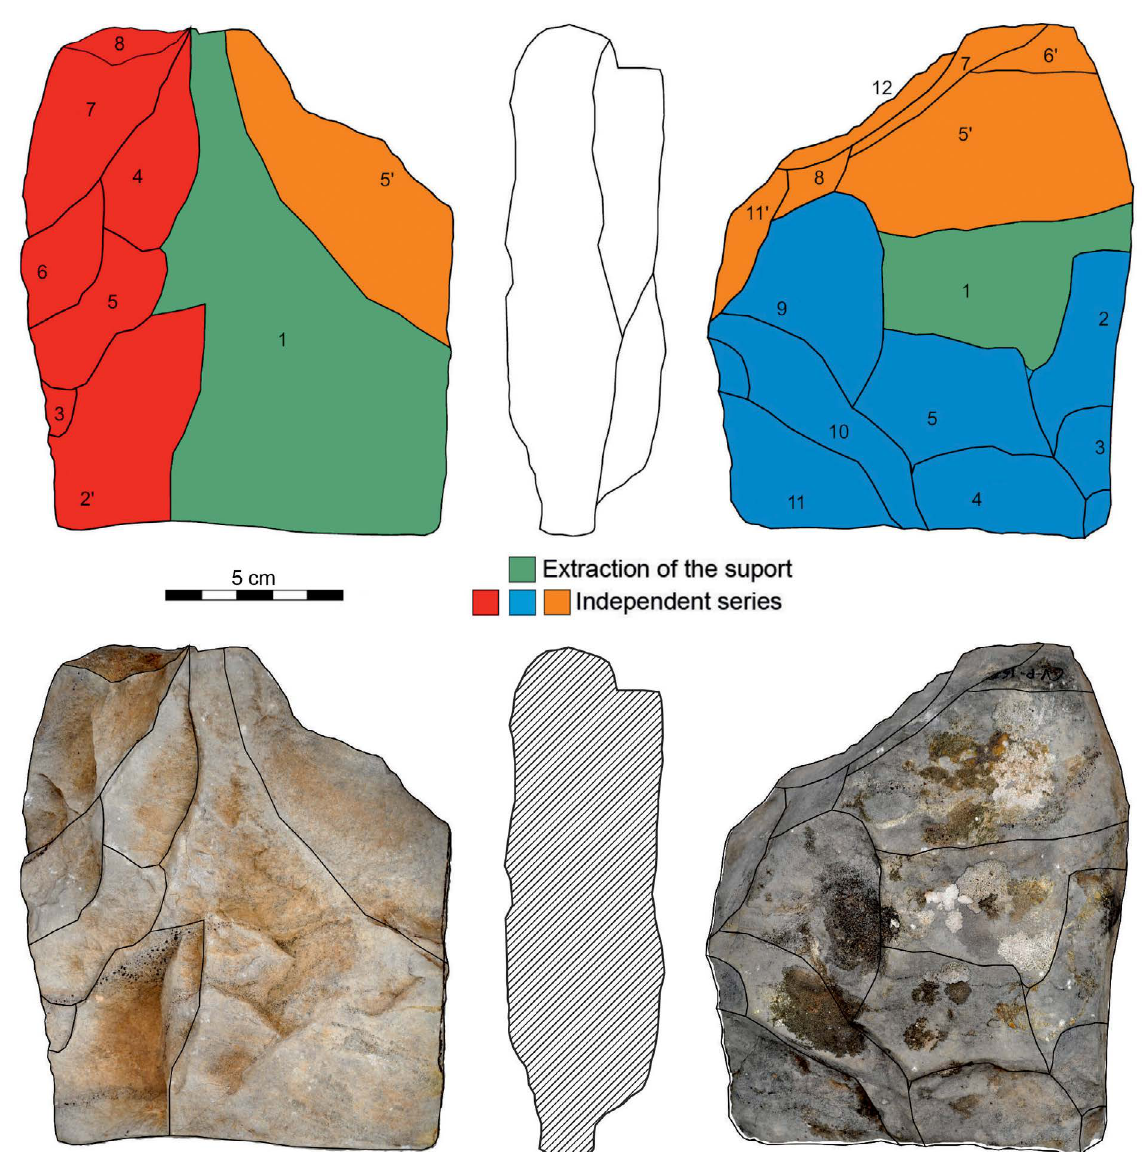
Figure 12. Diacritic scheme of knapping preform No.